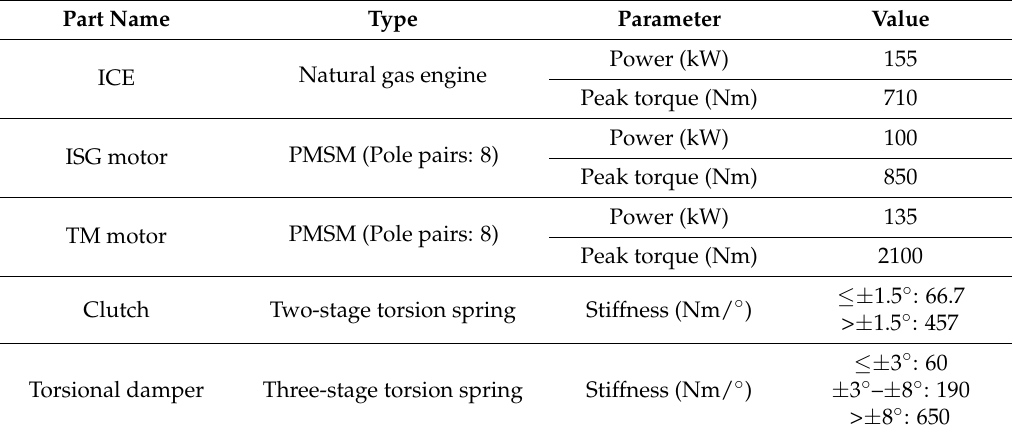
Figure 1. Schematic diagram of the hybrid powertrain system. Table 1. Main components and parameters of the hybrid system [31].